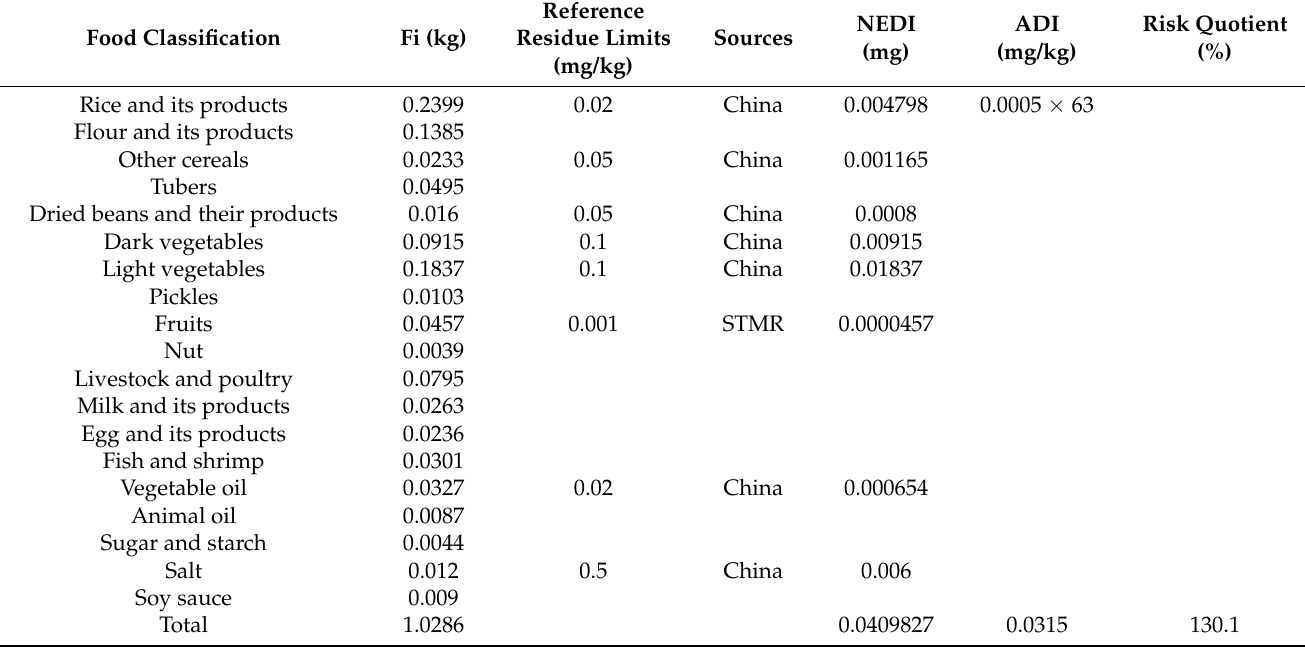
Table 3. The risk evaluation of emamectin benzoate in